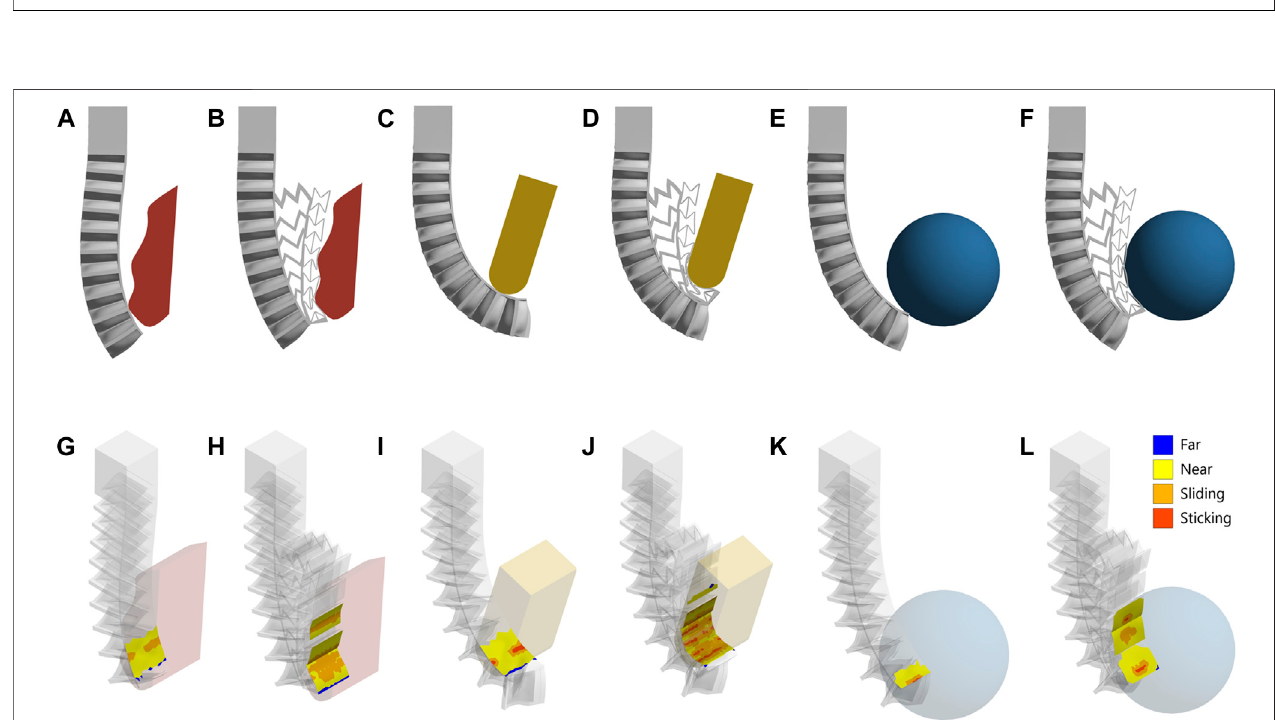
FIGURE 5 | Tip force results and setup. (A) Experimental and FEM tip forces for the soft monolithic fi nger under different applied positive pressures. (B) Tip force measurement setup.